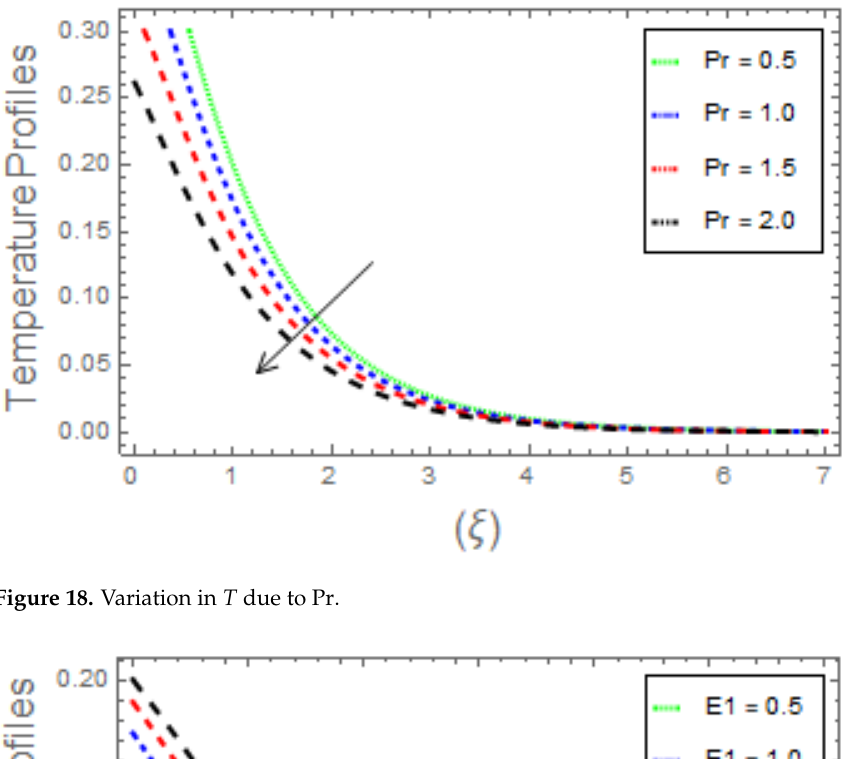
( ) E effect on fluid C ξ profiles. As estimated, the 1 E . 1